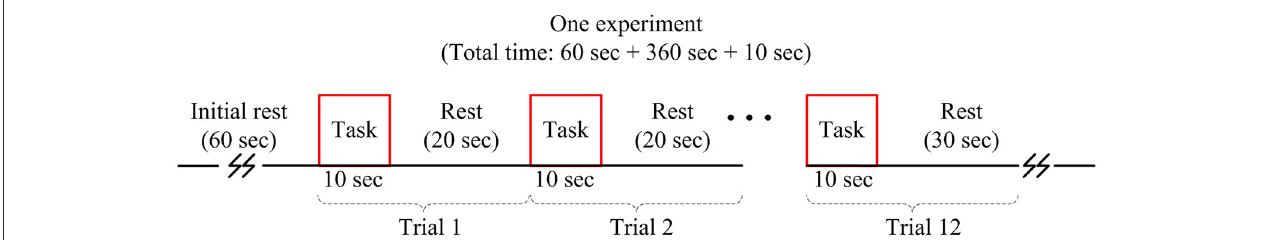
FIGURE 2 | Experimental paradigm used for acquiring brain signals.